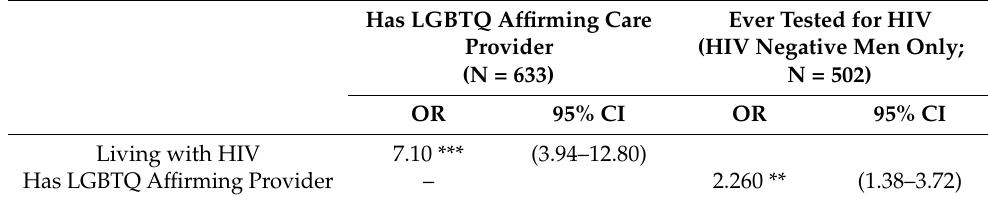
Table 2. Odds of reporting an LGBTQ affirming provider and ever testing for HIV among a sample of midlife and older gay and bisexual men in the US south,